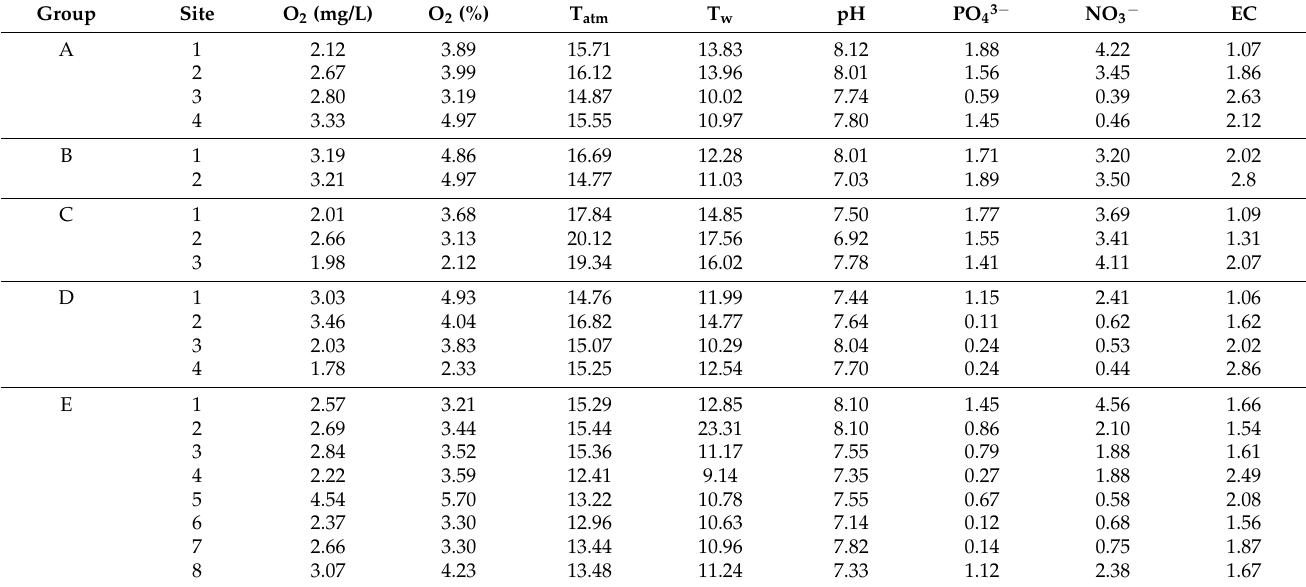
Table 1. Physico-chemical measurements of the 21 monitored Mediterranean temporary ponds within the study area. Parameters in alphabetical order: EC = electric conductivity ( µ S/cm); NO 3 − = nitrate (mg/L); O 2 = dissolved